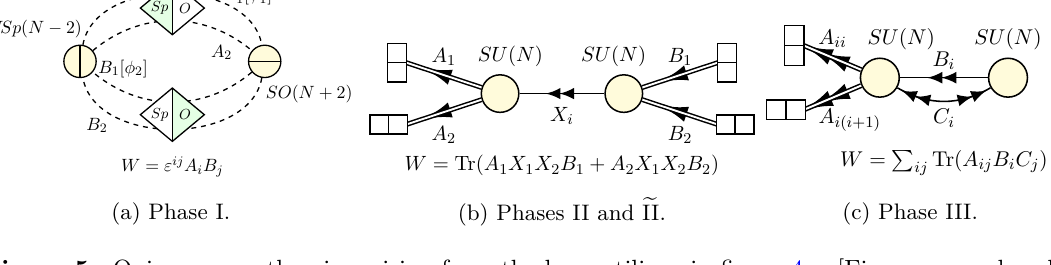
Figure 5. Quiver gauge theories arising from the brane tilings in figure 4. [Figures